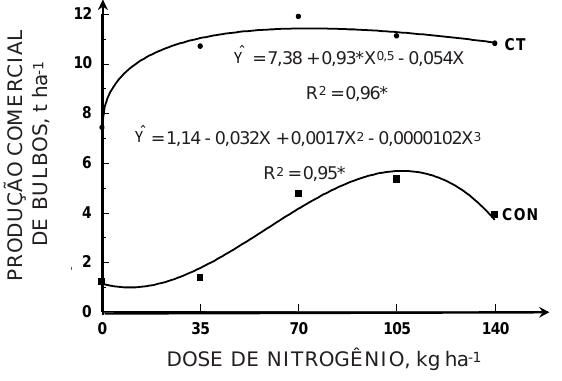
Figura 4 . Produção de bulbos comerciais por plantas de alho provenientes de cultura de tecidos (CT) e multiplicação convencional (CON), consideran- do as doses de nitrogênio. * significativo a 5%, pelo teste